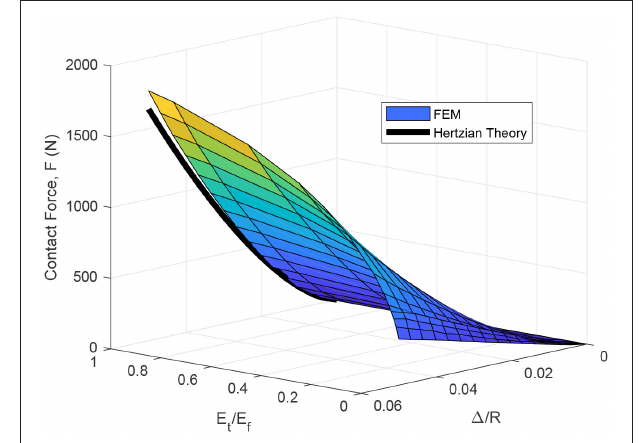
FIGURE 6 | Variation of contact force with respect to the strain hardening and applied displacement for material set 1 (numerical results).